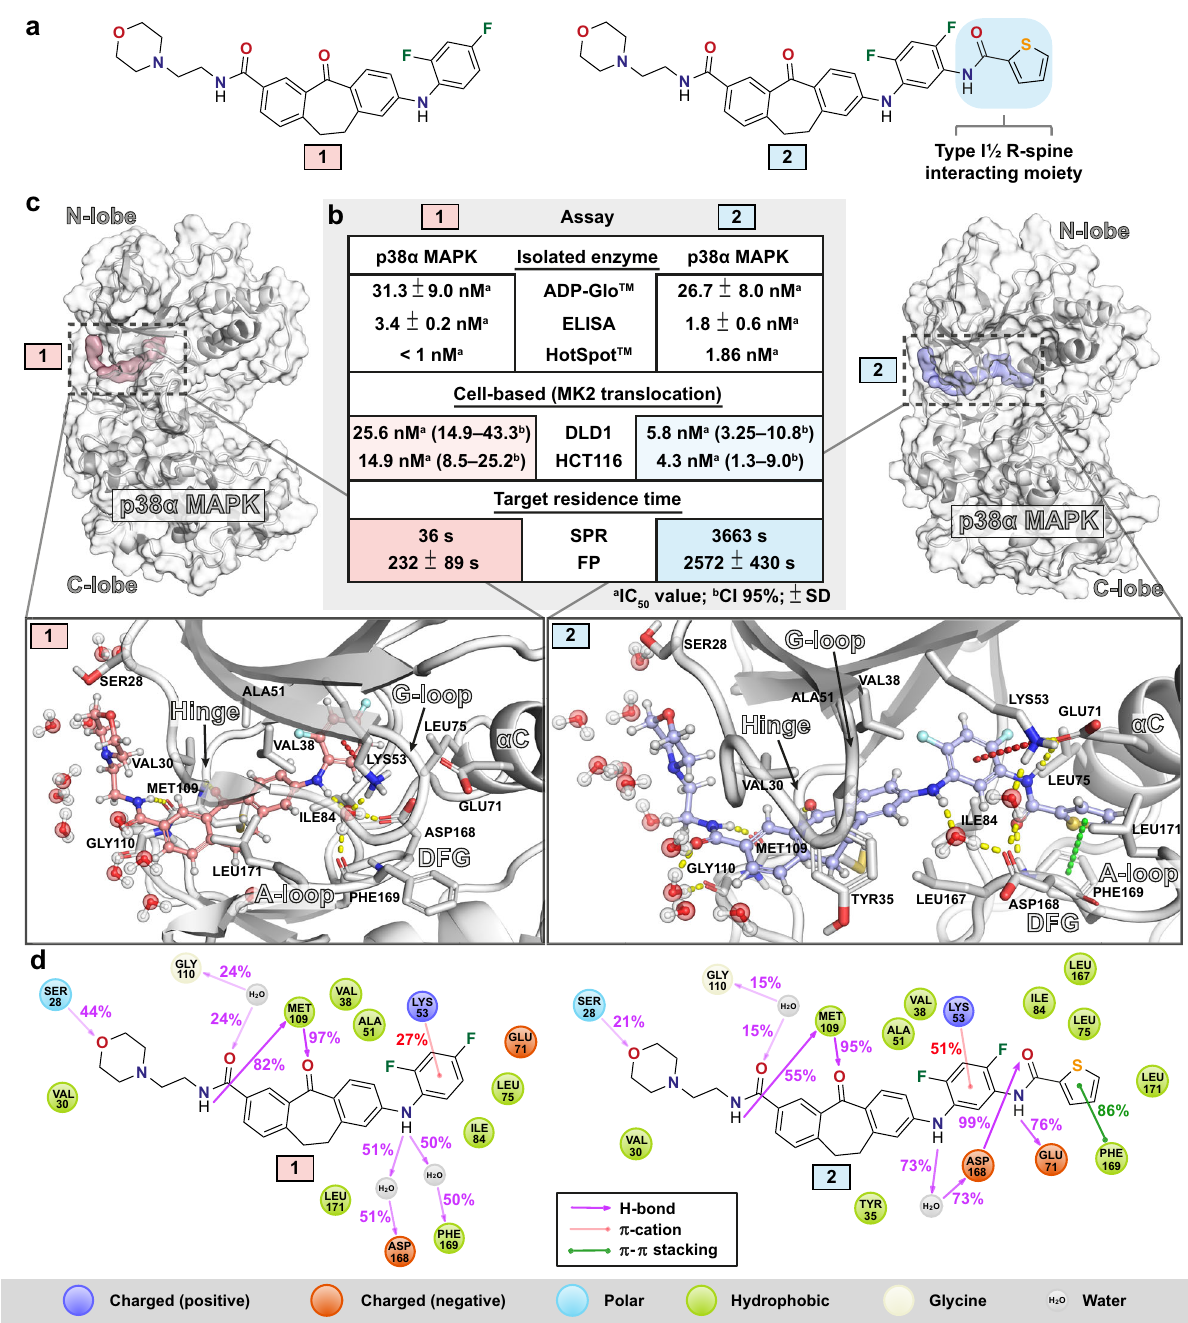
Fig. 1 Compounds 1 and 2 biological activities and binding modes to p38 α MAPK. a 1 and 2 are structurally identical, except 2 has an additional thiophene-2-carboxamide group. b Biological activity of 1 and 2 in selected assays. Data for ELISA and SPR were reported earlier by our group 27,28 . (ADP- Glo, ELISA, DLD1, HCT116, FP: n = 3; SPR n = 2; HotSpot, n = 1). c Binding modes of 1 and 2 shown with representative snapshots obtained from MD simulations (the snapshots were selected to re fl ect the observed protein ligand interactions; see d ). In the fi gure that is illustrating the whole kinase, molecular surface of p38 α MAPK is displayed in white, and molecular surface for 1 and 2 are shown in light red and light blue, respectively. In the close-up image of the binding site, the key interaction residues are shown with sticks together with solvent molecules in the close proximity of the ligand. Ligands are displayed with ball and stick representations using light red and light blue colors for carbon-atoms of 1 and 2 , respectively. H-bonds shown with yellow, π – cation with red and π – π stacking with green dashed lines. d 2D-representation of protein – ligand interaction frequencies. Displayed are the most frequent H-bond, π – cation, and π – π stacking interaction frequencies (interactions with >15% frequency are shown). Source data are provided as a Source Data fi